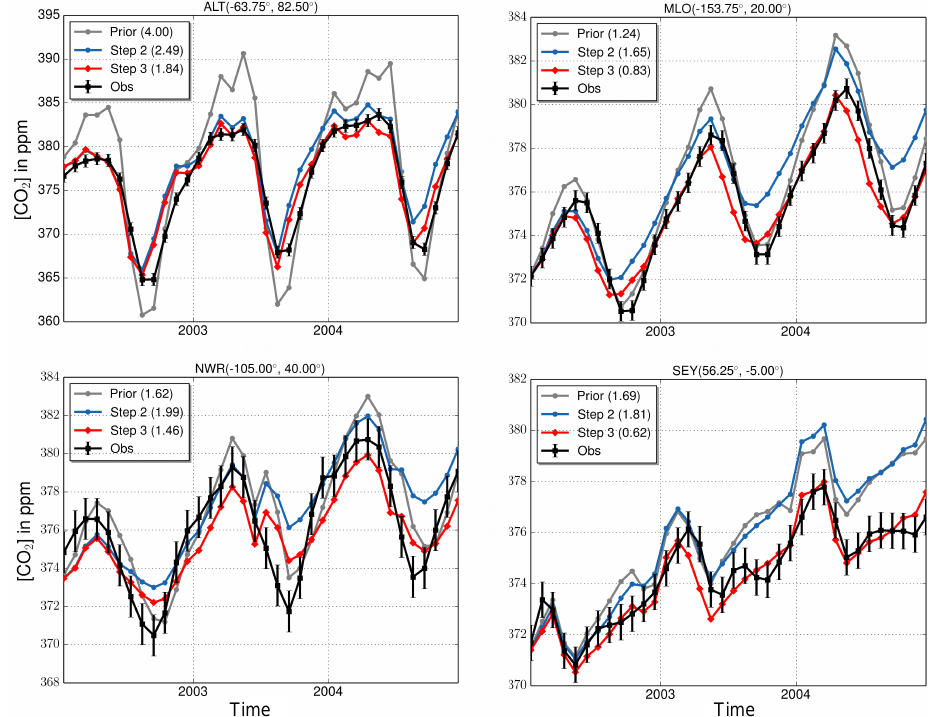
Figure 6. Monthly mean atmospheric CO 2 concentrations after step 3 of the optimization, for several stations over the period 2002–2004 of the optimization. The observations (black), the prior model (gray) and the posterior model after step 2 (blue) and step 3 (red) are displayed. Numbers in parenthesis correspond to